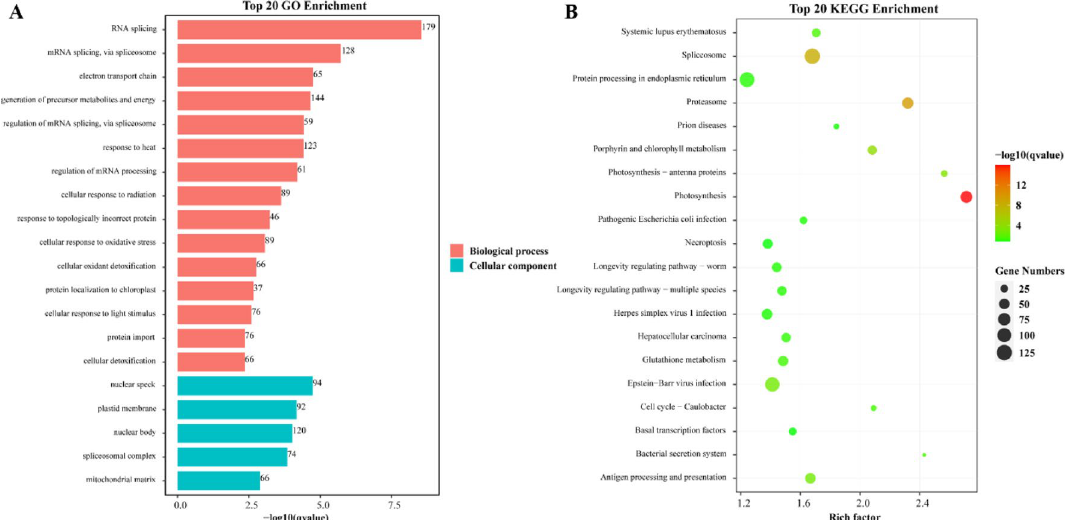
Figure 13. GO and KEGG analysis of the genes in the co-expression network of the MaLOX genes. ( A ) GO functional annotation; ( B ) KEGG pathway